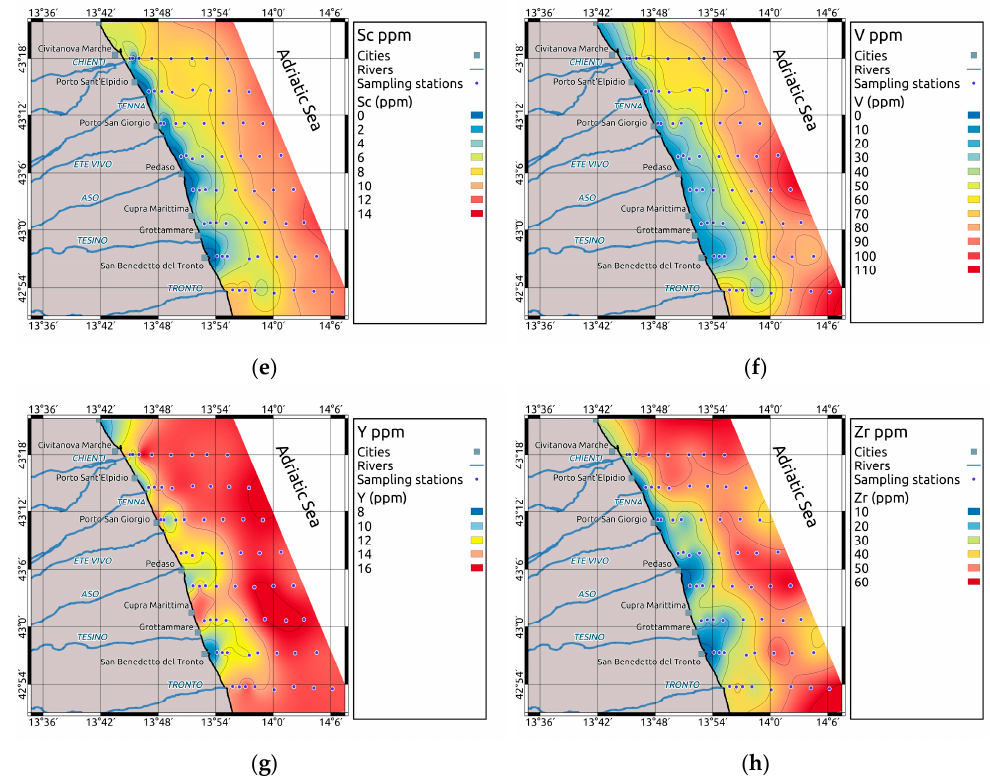
Figure 8. Areal distribution of the elements in surface sediments with C f < 1 in all samples. ( a ) Co, ( b ) Cr, ( c ) Cu, ( d ) Ni, ( e ) Sc, ( f ) V, ( g ) Y, and ( h ) Zr.